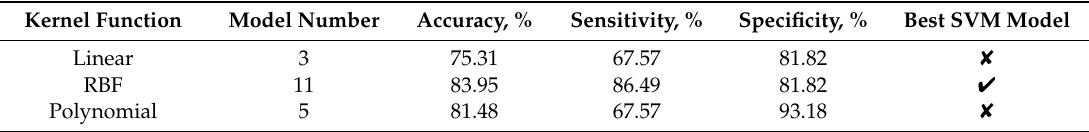
Table 18. Summary of the best SVM models of the linear kernel function, RBF kernel function and polynomial kernel function.